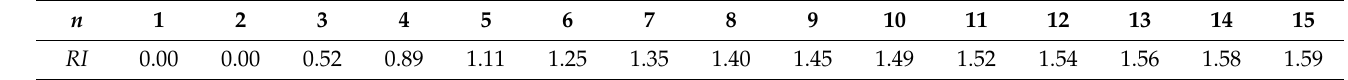
Table 2. The random index (RI) values determined by Saaty and Ozdemir